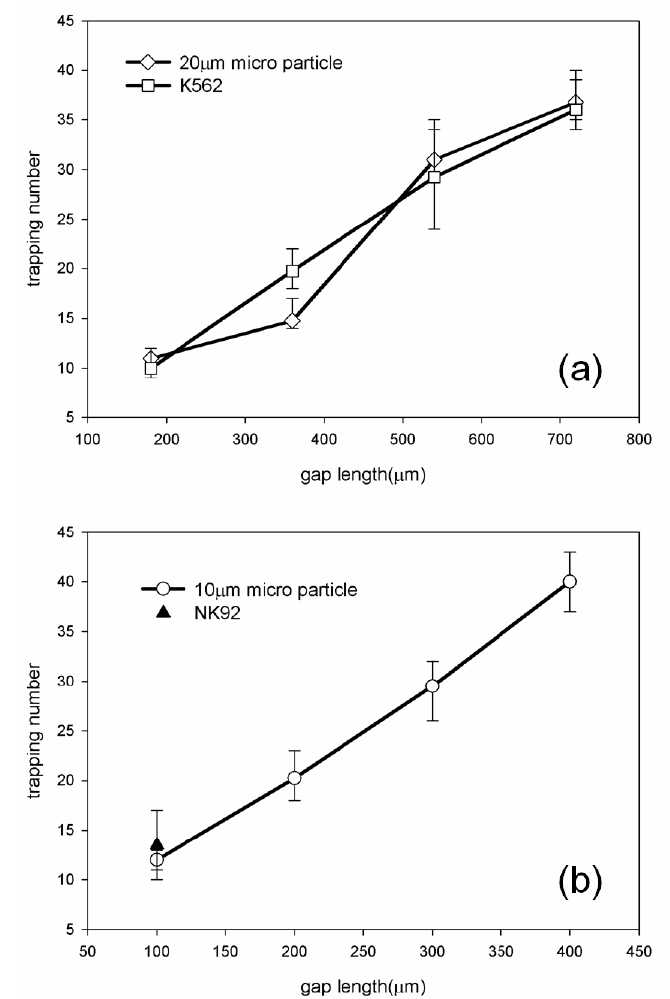
Figure 5. The relationship between the trapping number and the gap length. ( a )The trapping numbers of 20-µm particles and K562 cells increased at the gap length from 200 µm to 700 µm. ( b ) Trapping number of 10-µm particles increased as the gap length